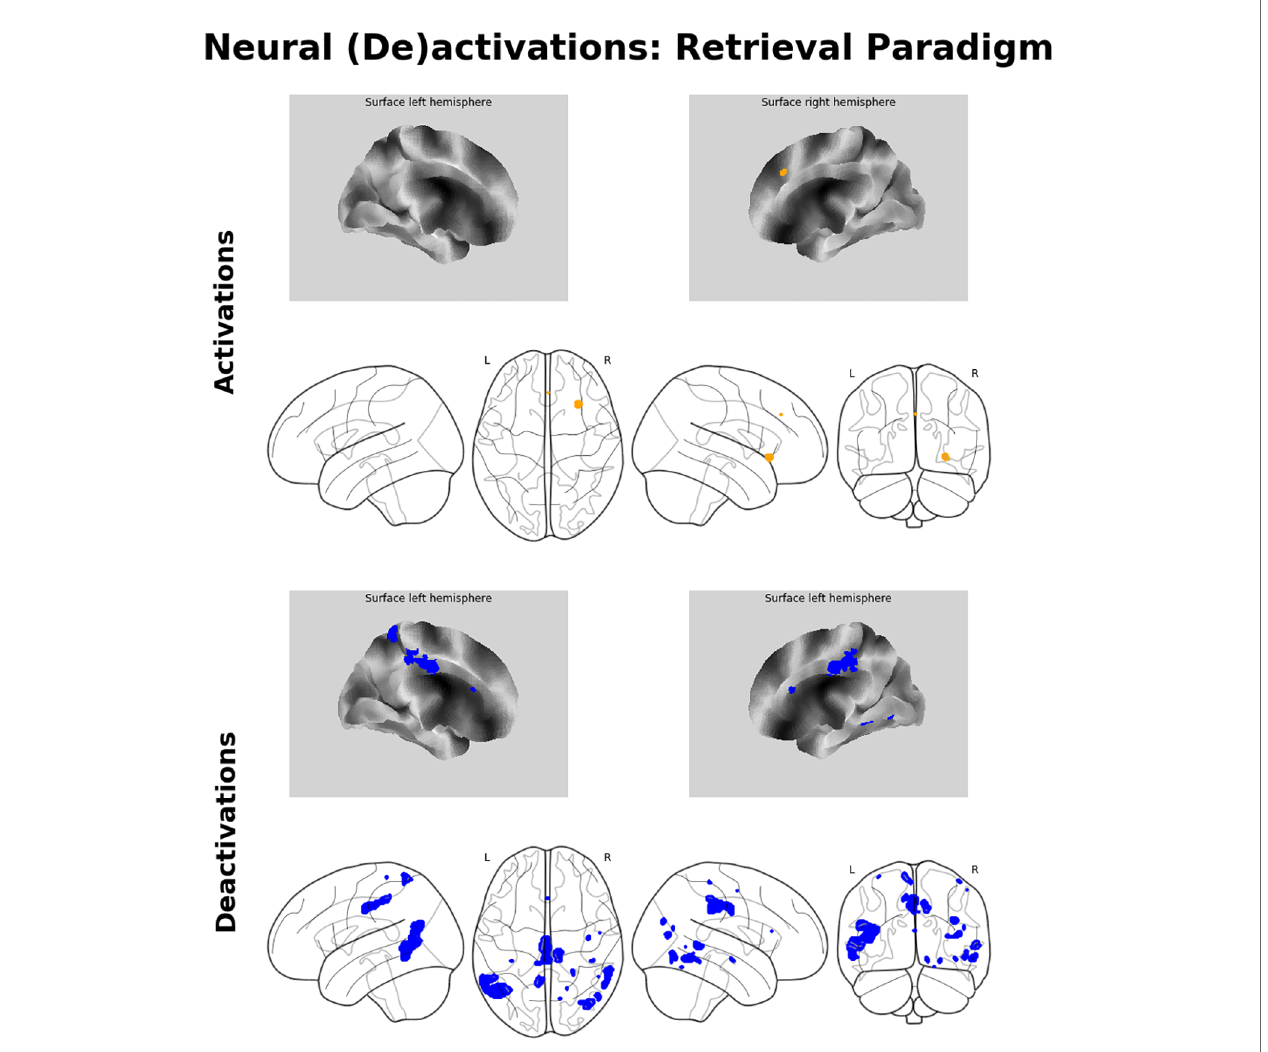
FIGURE 4 | Neuroimaging fi ndings. Medial wall surface renderings and glass brain images of brain activations (orange) and deactivations (blue) related to memory recall. Depicted (de-)activations were thresholded at p FWE < 0.05 at peak level with a minimum cluster size of 15 contiguous